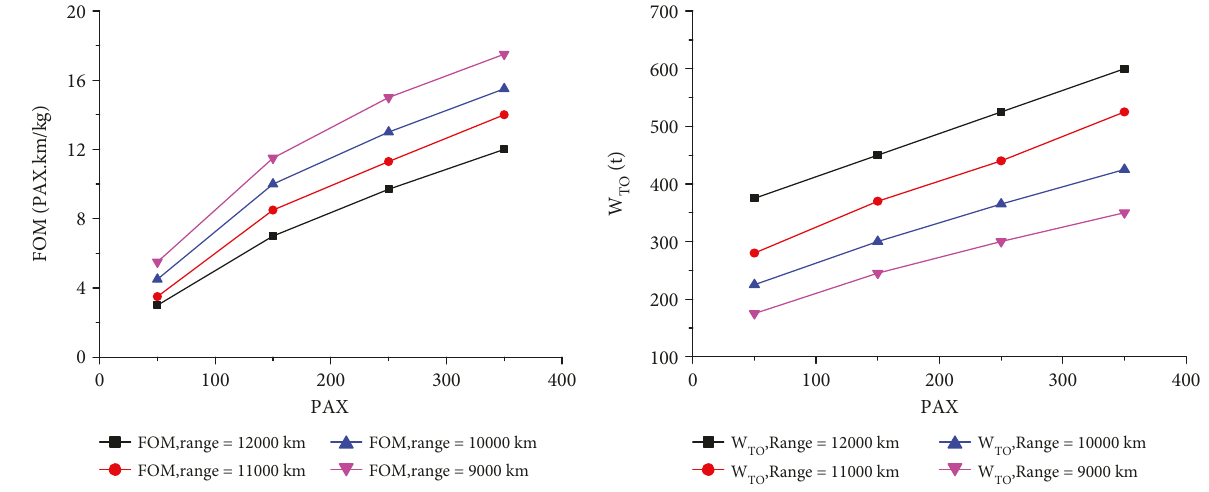
Figure 7: In fl uence of R and PAX on FOM and W